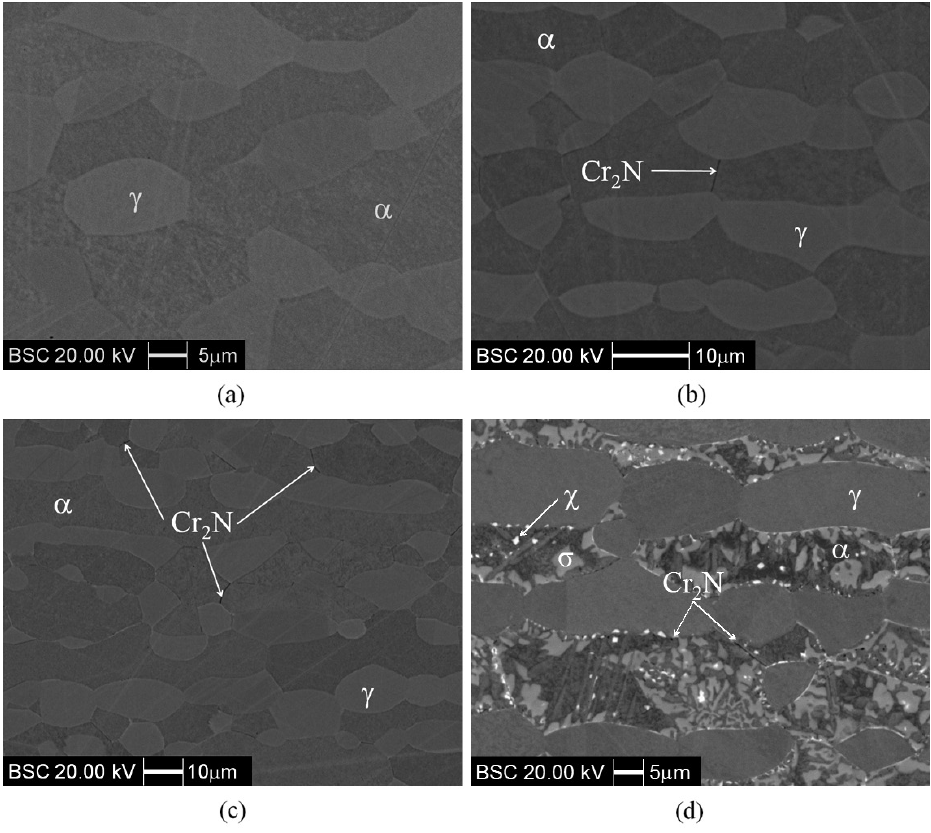
Figure 3. SEM-BSC images of: (a) solution treated sample, (b) sample aged 1 h at 650°C, (c) sample aged 4 h at 650°C and (d) sample aged 360 h at 650°C. Ferrite (dark grey), austenite, sigma (light grey) and chi (white) phases can be distinguished, besides the presence of chromium nitrides (dark points at grain